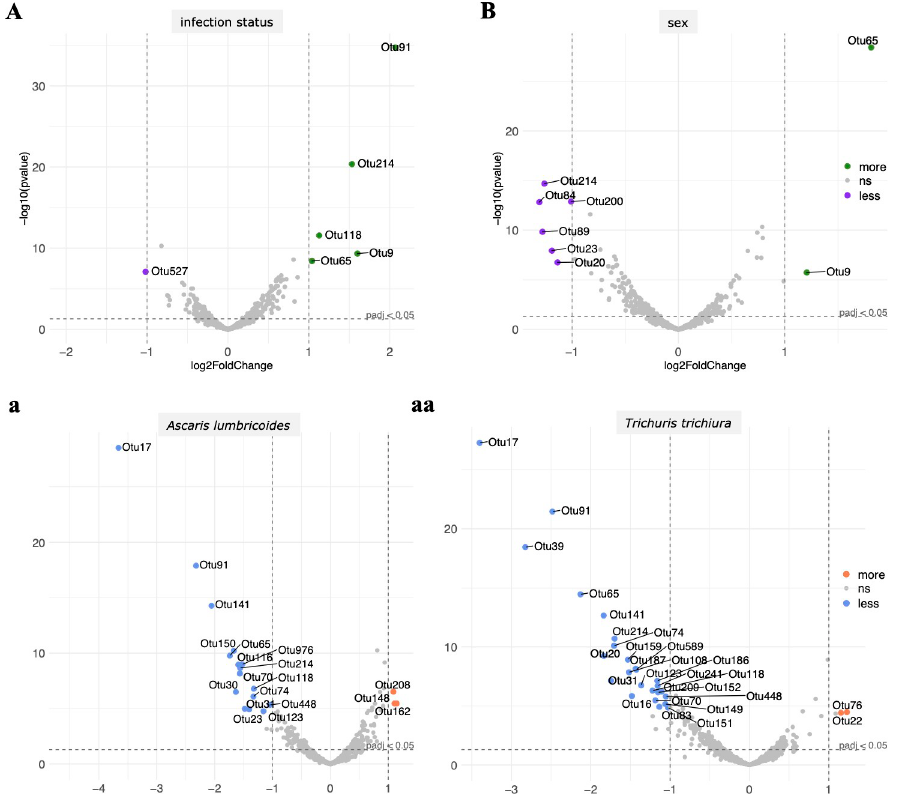
Fig 2. Abundance of significantly increased and decreased operational taxonomic units (OTU) as per log fold change influenced by soil-transmitted helminth (STH) infection status estimated by multiplexed-tandem qPCR (MT-PCR) (A) for Ascaris lumbricoides (a) and Trichuris trichiura (aa) and sex (B). Green or orange OTUs are found to be significantly more abundant and purple or blue OTUs significantly less abundant (ns = not significant). For STH infection status (A) OTU 91 Akkermansia muciniphila , OTU 214 Prevotella , OTU 65 Bacteroides coprophilus , OTU 118 Ruminococcaceae, OTU 9 Tenericutes are more and OTU 527 Bifidobacterium adolescentis is less abundant. For sex (B) OTU 65 Bacteroides coprophilus , OTU 9 Mollicutes, OTU 214 Prevotella , OTU 84 Parabacteroides , OTU